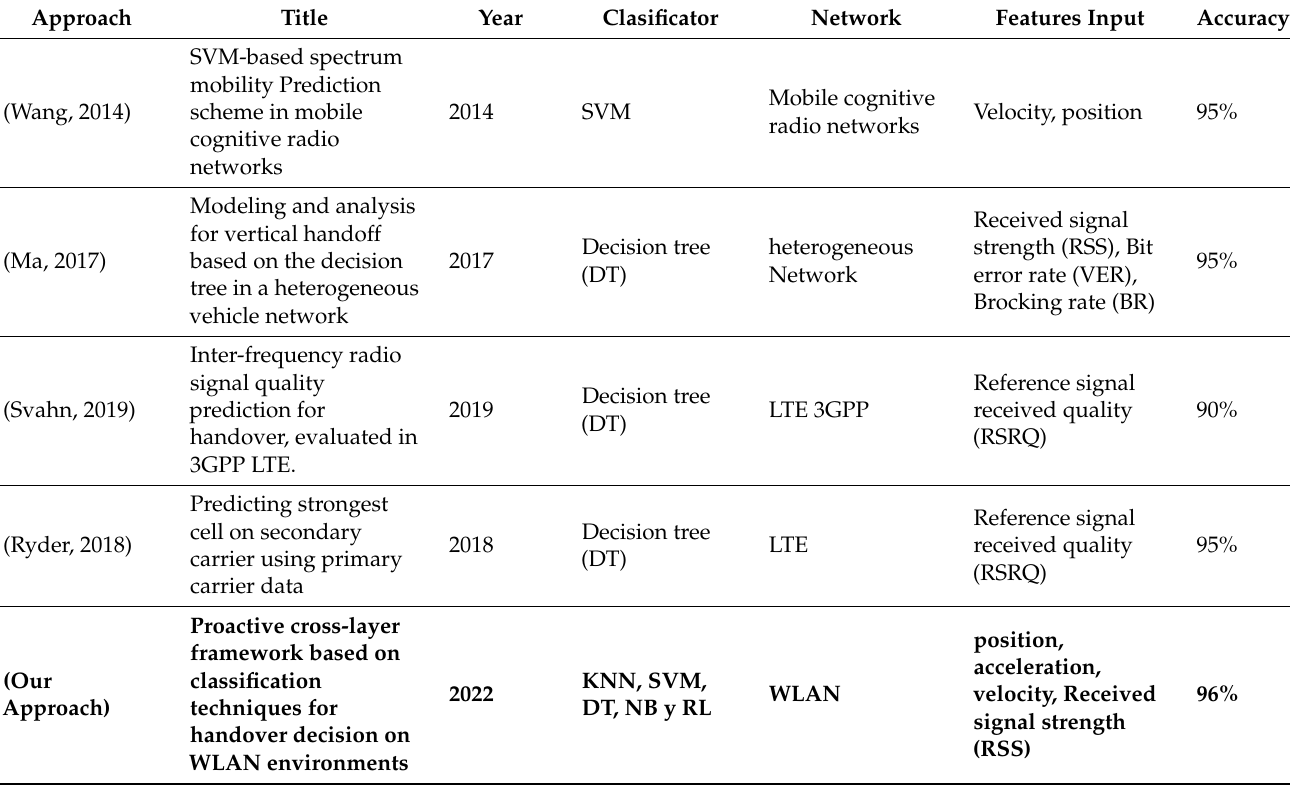
Table 5. Comparison of results obtained versus handover decision